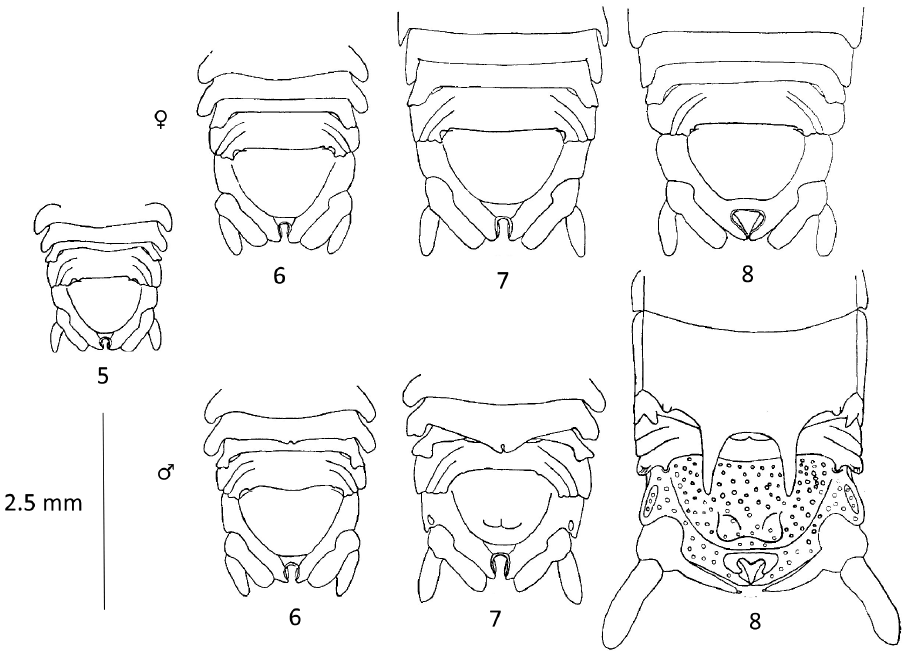
Figure 4. Dorsal views of the posterior halves of the bodies of various life history stages ( 5–8 ) of Dy- namene bidentata . 5 juvenile Upper row female stages 6, 7, 8 (ovigerous) Lower row male stages 6, 7, 8 . Adapted from Holdich